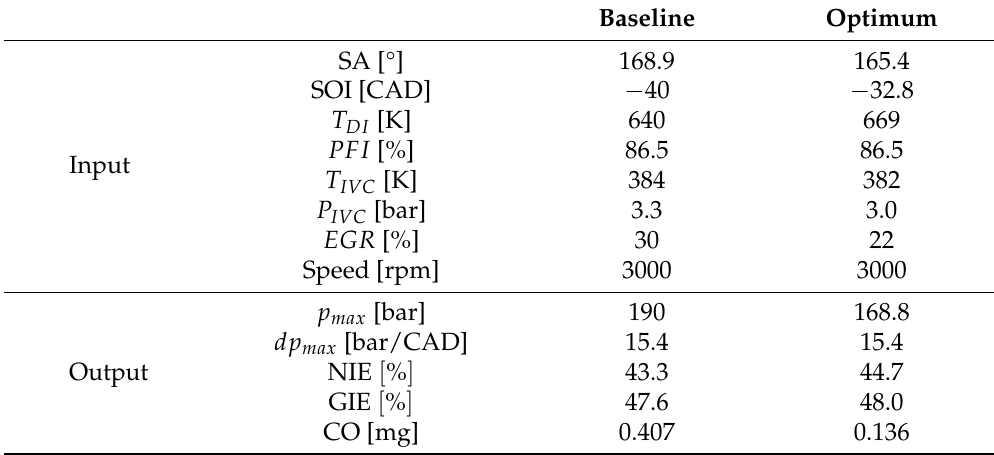
Table 7. Operating condition and performance parameter of the optimum case.